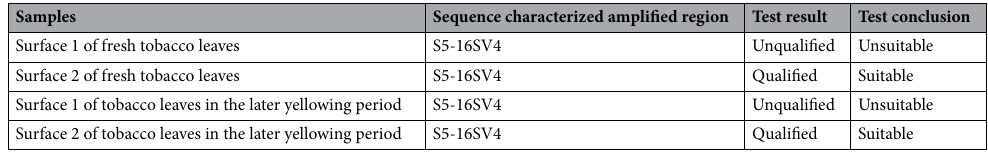
Table 1. Comparison of effects of the two methods for sampling microbes on the surface of tobaccos. 1 and 2 represent the first and second methods for sampling microbes on the surface of tobaccos, respectively.